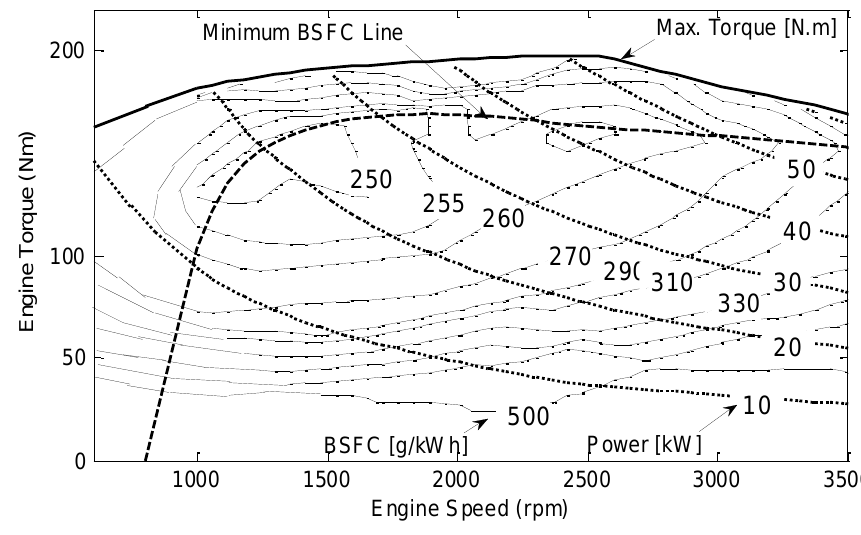
Figure 2. Experimental brake specific fuel consumption map of the